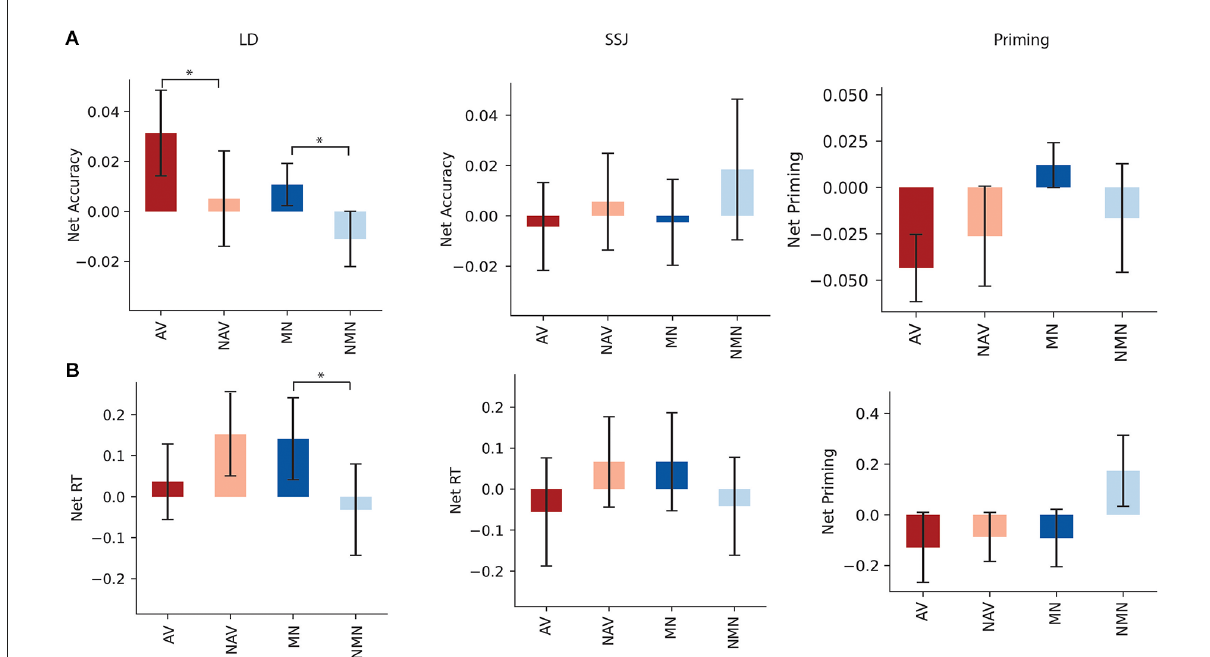
FIGURE4 Panels (A,B) show the net accuracy and net RT following aIPL stimulation for LD, SSJ, and priming. Net accuracy refers to the difference between accuracy following active and sham stimulations. Net RT refers to the difference in z score of response time between active and sham stimulation. Significant differences were marked with asterisk signs ( p < 0.05). Tasks abbreviations: AV, action verbs; NAV, Non-action verbs; MN, Manipulable nouns; NMN, Non-manipulable